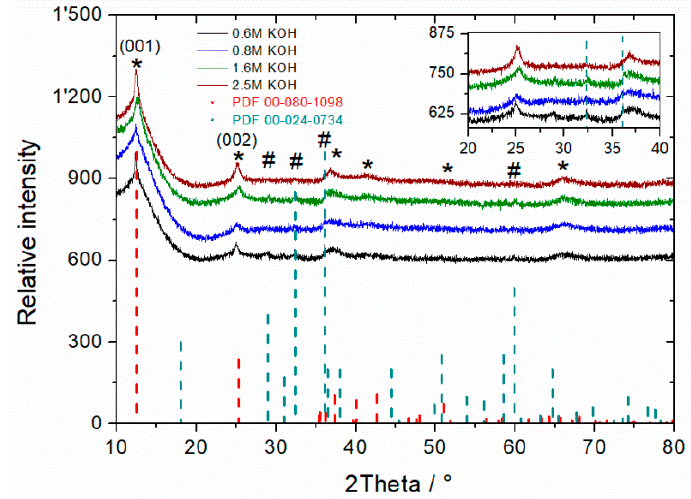
Figure 1. Diffraction pattern of MnO 2 synthesized at different KOH concentrations and 96 h reaction time. K- Birnessite (PDF 00-080-1098 = *) and hausmannite (PDF 00-024-0734 = #) are shown as references. Inset: Evaluation of hausmannite reflection peaks at 2 θ ~32.5° and ~36°.